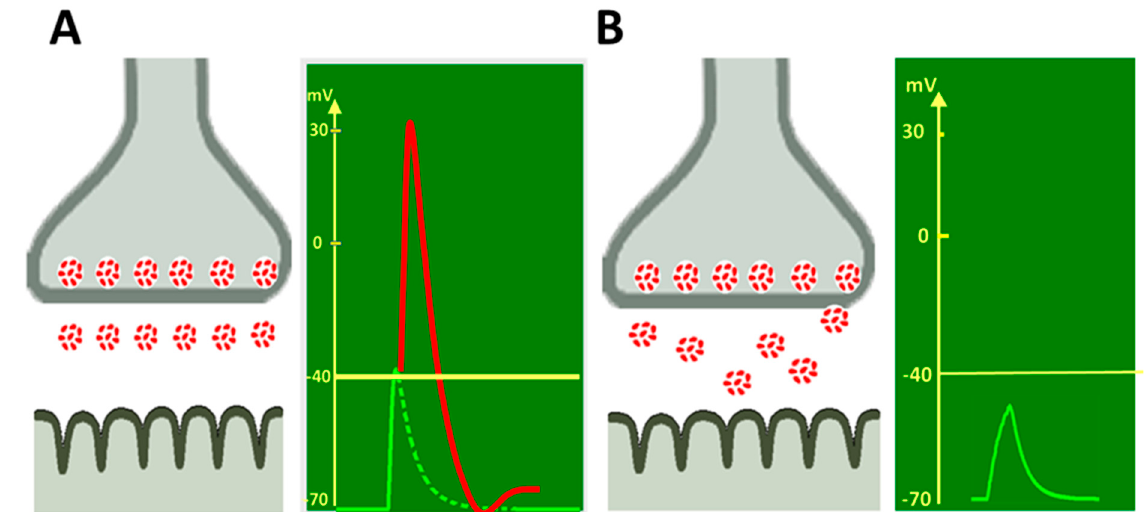
Figure 1. Synchronous and asynchronous ACh quanta release at NMJ. ( A ) Synchronous release of ACh quanta from nerve terminal triggers EPP in the muscle fiber with sufficient amplitude (green line), needed to generate action potential (red line) and subsequent muscle contraction. ( B ) Asynchronous release of ACh quanta triggers smaller signal (green line) in the muscle fiber, insufficient to cause action potential generation and muscle fiber contraction.